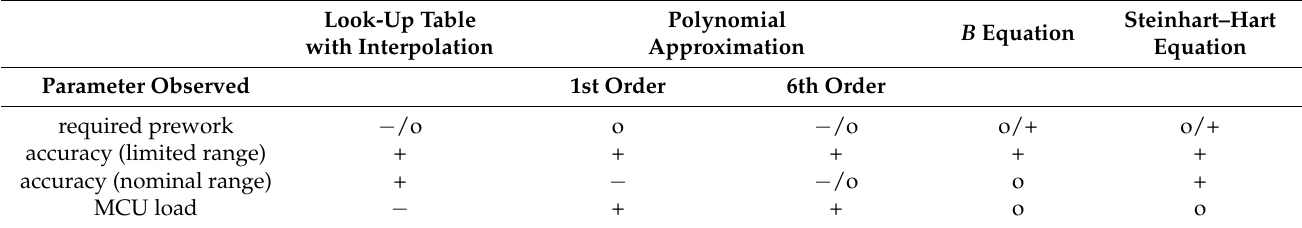
Table 1. Comparison of key parameters of calculation